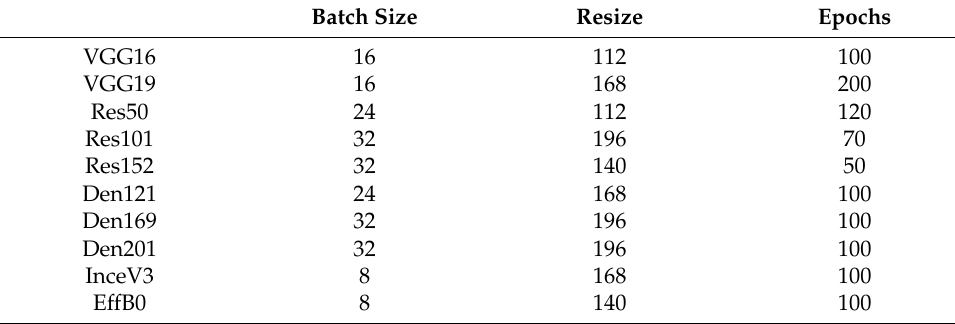
Table 3. Best settings for the considered CNN models.